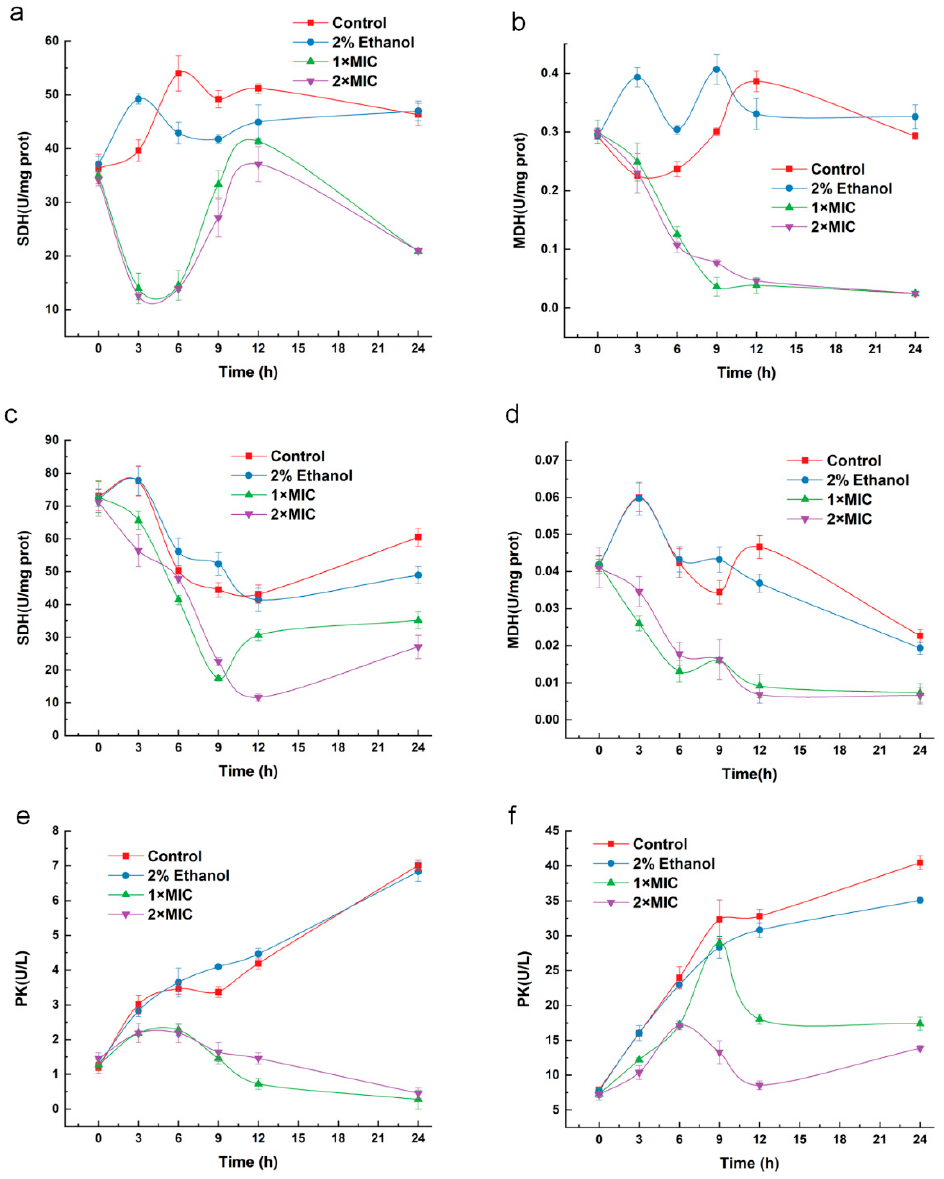
Figure 7. Effects of 3-carene on the activity of succinate dehydrogenase (SDH), malate dehydrogenase (MDH) and pyruvate kinase (PK) in bacteria. ( a ) SDH of B. thermosphacta , ( b ) MDH of B. thermosphacta ; ( c ) SDH of P. fluorescens , ( d ) MDH of P. fluorescens ; ( e ) PK of B. thermosphacta , ( f ) PK of P. fluorescens.